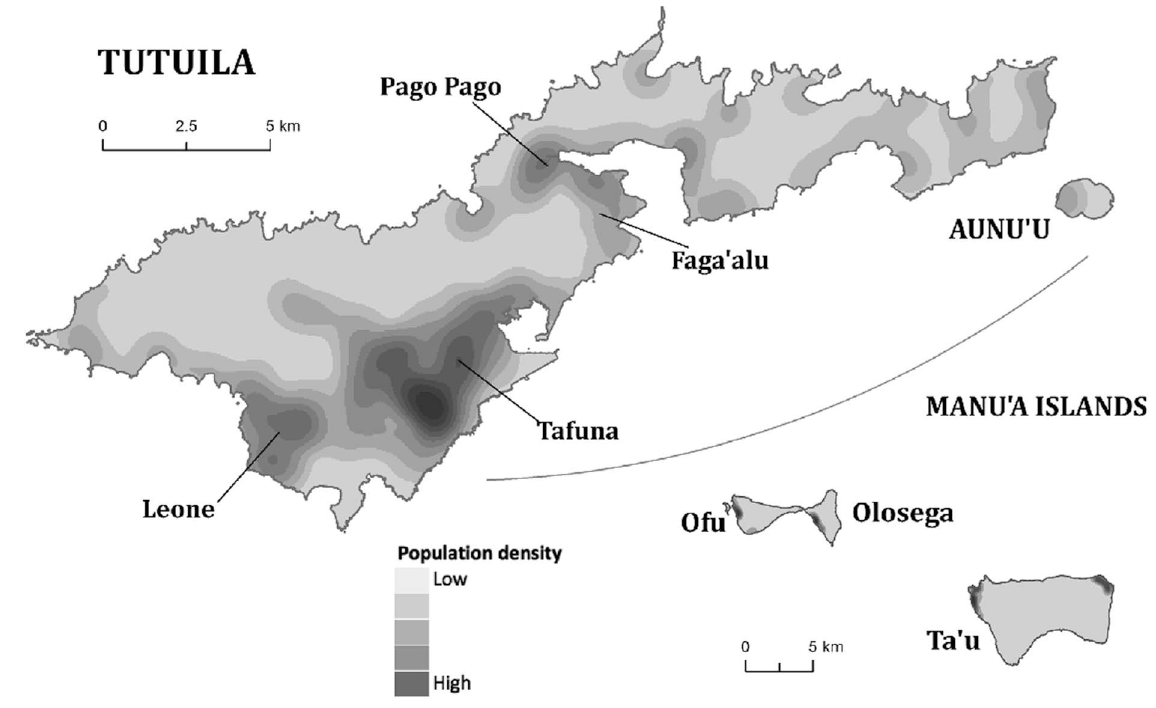
Figure 3. Population distribution on the islands of American Samoa 2010 (Reproduced from Lau et al. (23).